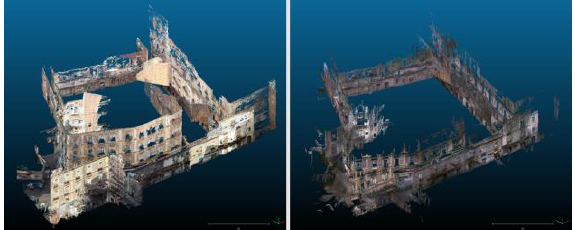
Figure 6 . On the left: 360 SFM (GOPRO Fusion 360) cloud. On the right: SLAM (BLK2GO)